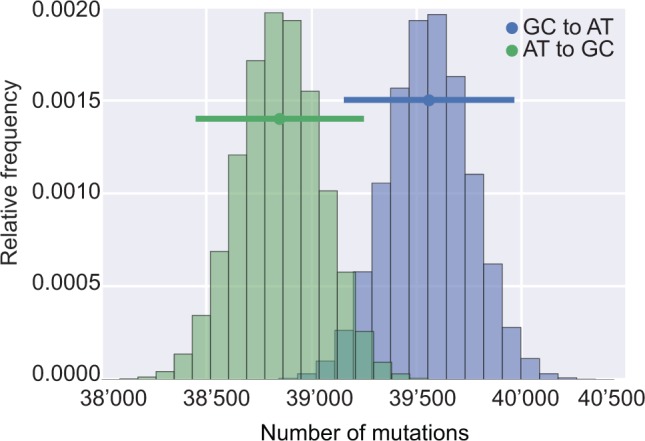
The AT content of the Spraguea genome is near mutational equilibrium. To investigate the mutation process in Spraguea, we focused on mutations segregating in the intergenic genomic regions. Although these regions are highly AT-rich (79.2%), we counted similar numbers of AT to GC and GC to AT mutations segregating in contemporary Spraguea populations, suggesting that these regions are near mutational equilibrium. The observed number of mutations in each direction is indicated by a dot; the bars represent 95% confidence intervals based on resampling from a Poisson distribution with mean equal to the observed number of mutations. Based on the method of Hershberg and Petrov (2010), we estimate an equilibrium AT content of 79.5% for these regions. Thus, the AT content of both the intergenic and, by extension, the coding regions of the Spraguea genome (which have a mean AT content of 74.7%) are close to mutational equilibrium.